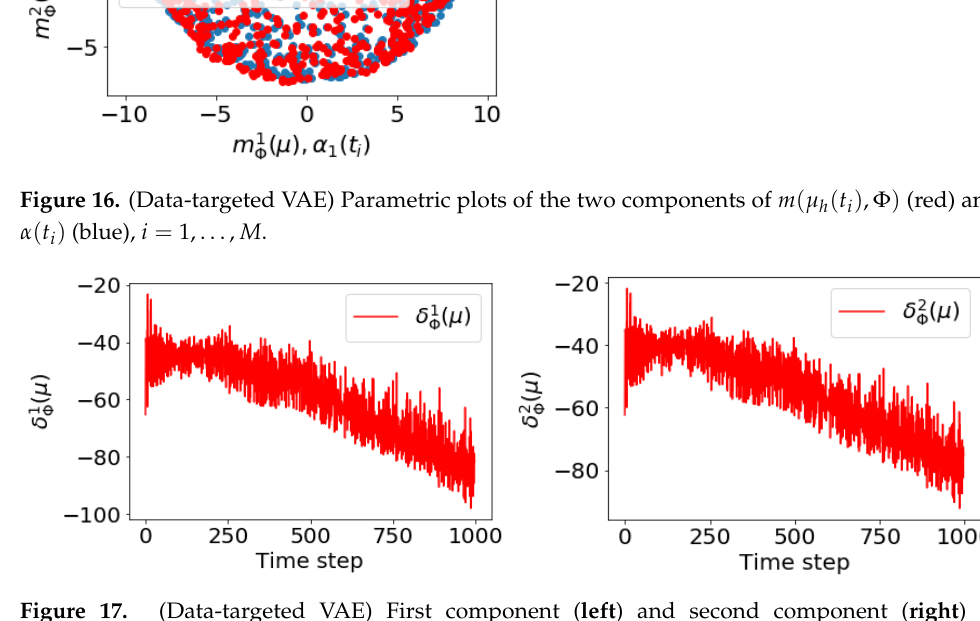
) − α ( t ) (cid:107) 2 R ) , z (cid:48) ∼ q Φ ( z (cid:48) | µ (cid:107) z (cid:48) ( t i i N i = 1